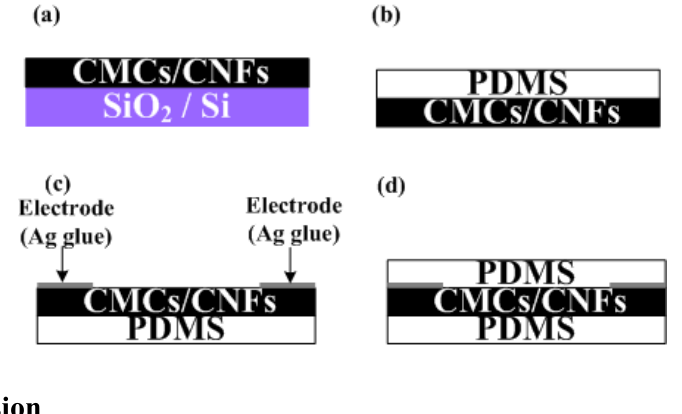
Figure 1. Fabrication process of CMC pressure sensor. ( a ) CMCs and CNFs were grown on SiO 2 by CVD; ( b ) CMCs and CNFs were transferred on PDMS; ( c ) Ag glue was coated on both edges of the sample as electrode; ( d ) PDMS was coated on the Ag electrode to complete the CMC pressure sensor.